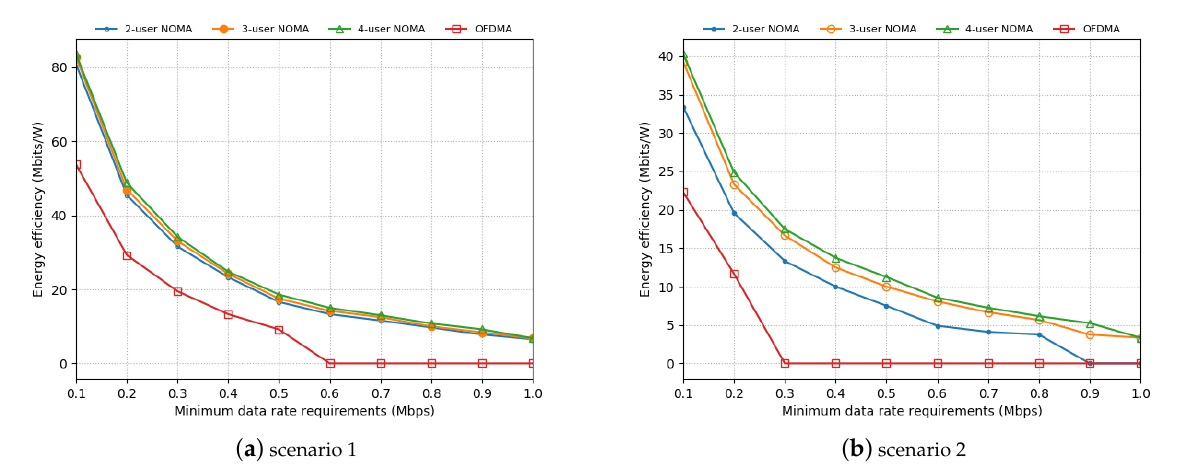
Figure 5. Energy efficiency versus minimum data transmission rate requirements of each user for NOMA systems equipped with the proposed user clustering and power allocation methods and OFDMA based